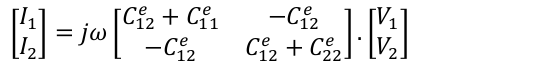
FIGURE 6. Equivalent circuit model of the 1m-long open-circuited coaxial cable problem